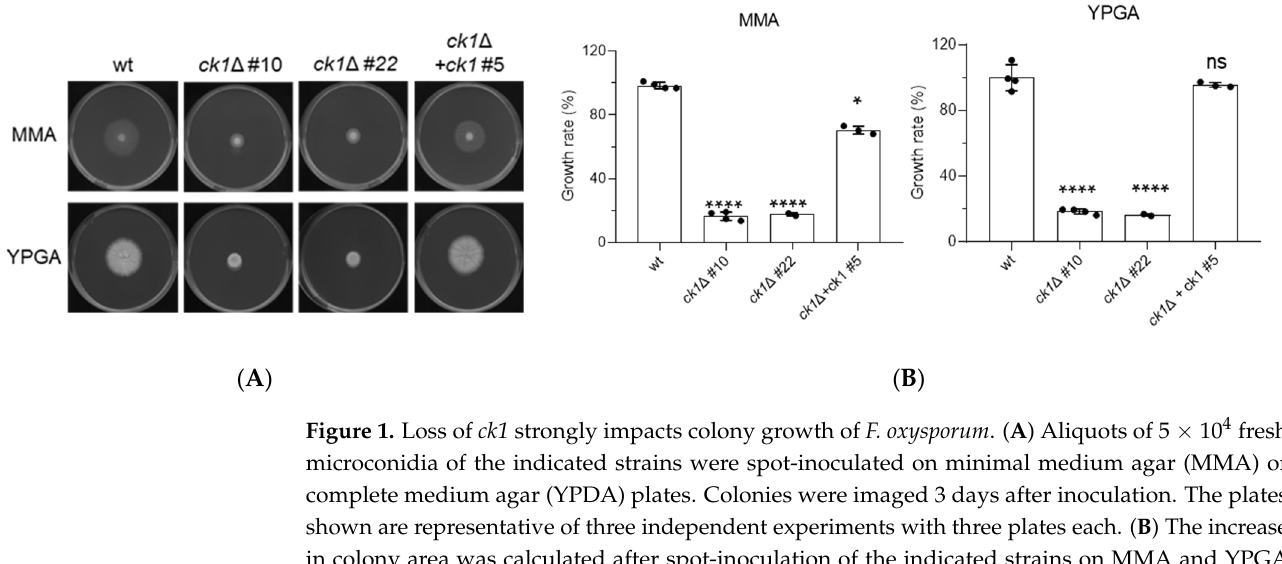
Figure 1. Loss of ck1 strongly impacts colony growth of F. oxysporum . ( A ) Aliquots of 5 × 10 4 fresh microconidia of the indicated strains were spot-inoculated on minimal medium agar (MMA) or complete medium agar (YPDA) plates. Colonies were imaged 3 days after inoculation. The plates shown are representative of three independent experiments with three plates each. ( B ) The increase in colony area was calculated after spot-inoculation of the indicated strains on MMA and YPGA and normalized to that of the wt strain (100%). p < 0.05 (*), p < 0.0001 (****) and not significant (ns) versus wt, according to Welch’s t -test. versus wt, according to Welch’s t -test. Data show the mean and standard deviation from at least three independent experiments.